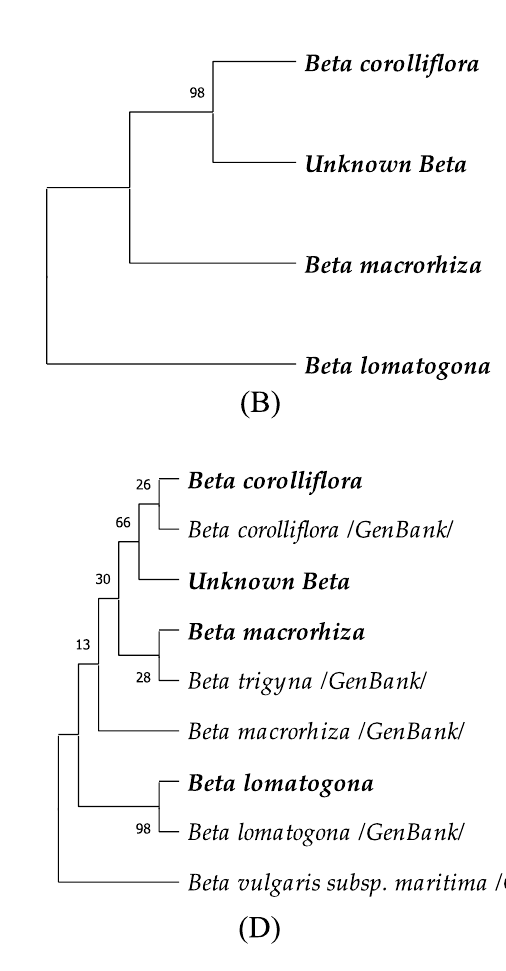
Figure 7. Phylogenetic relation of the wild beet species using maximum-likelihood (Tamura-Nei model) analysis, based on the partially sequenced alcohol dehydrogenase ( adh ) nuclear ( A , C ) and the trnL-trnF intergenic spacer (LF) chloroplast ( B , D ) markers. The numbers next to the branches indicate bootstrap percentages of 1000 replications (BP).